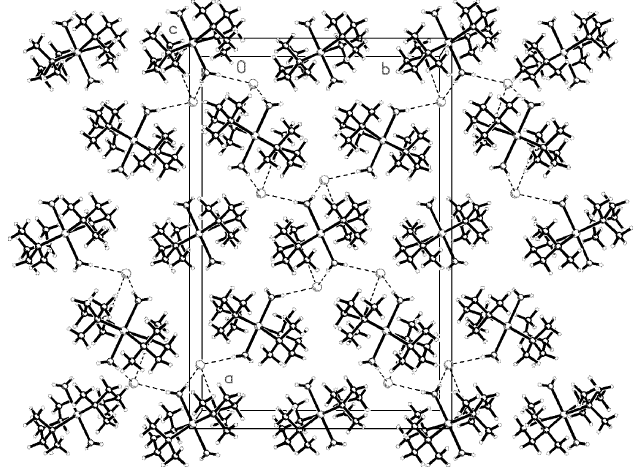
Figure 3 A partial packing diagram of the title compound viewed along the c axis showing the O—H (cid:2)(cid:2)(cid:2) Cl and N—H (cid:2)(cid:2)(cid:2) Cl intermolecular interactions (dashed lines) with the Cl (cid:3) ion, forming weak bifurcated hydrogen bonds.